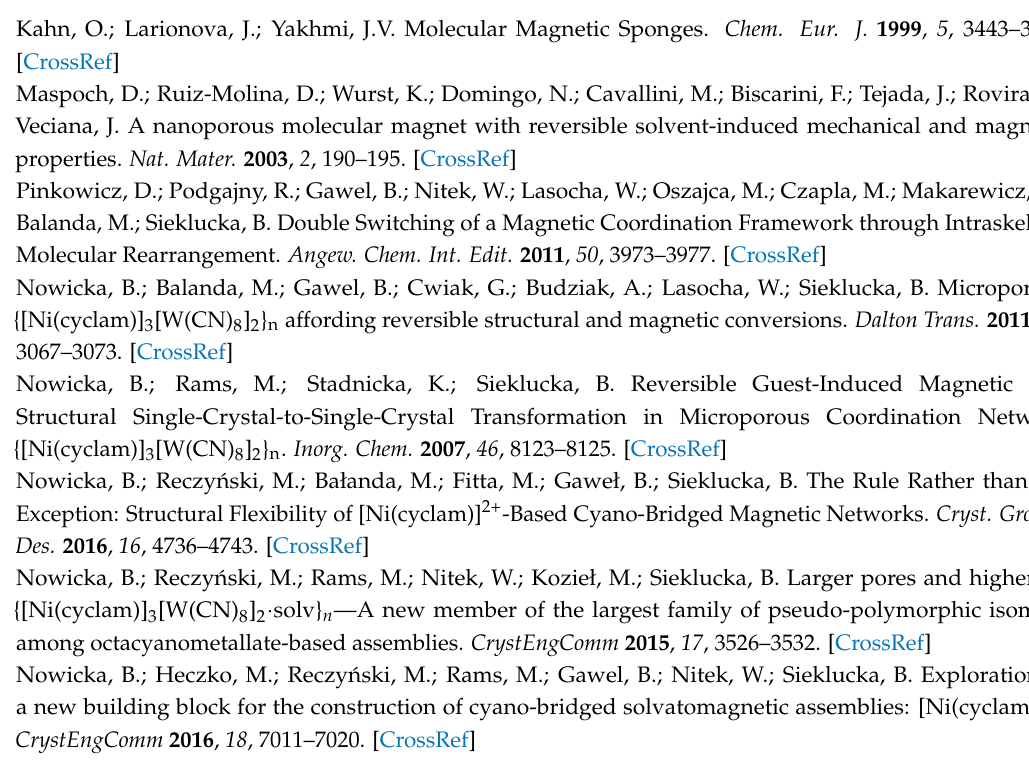
Figure S1: PXRD pattern for the rehydrated sample of 1 in comparison to 1 · 5H 2 O and 1; Figure S2: Mass loss upon dehydration of 1 · 5H 2 O monitored by dynamic vapor sorption method; Figure S3: PXRD pattern for sample obtained from [Cu(cyclam)](NO 3 ) 2 and Na 3 [W(CN) 8 ] by quick precipitation from water solution in comparison to 1 · 5H 2 O and 2 · 3H 2 O; Table S1: Continuous shape measure parameters for octa-coordinated W centers in the structures of 1 ·